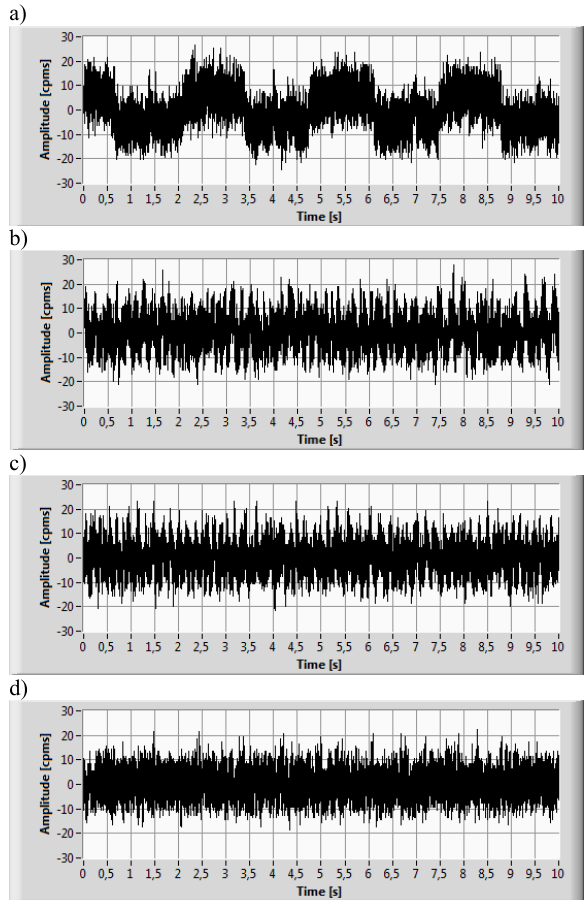
Fig. 4. Time records of signal x ( n ) (first 10 second) in the experiments: a) LIW5, b) LIW4, c) LIW2, d)